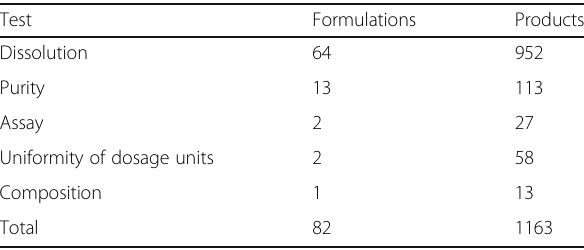
Table 3 Testing types and number of formulations or products tested by the Formulation